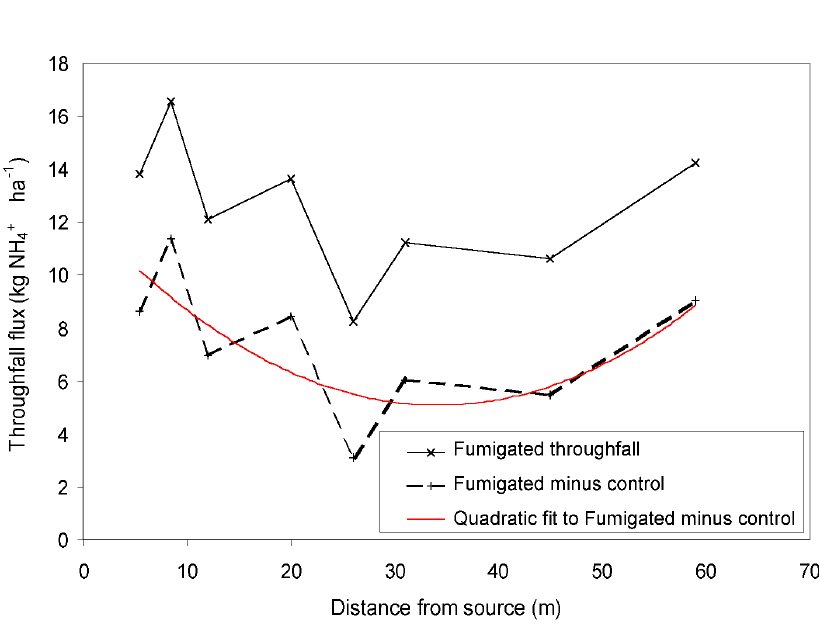
FIGURE 6. Total throughfall NH 4+ flux for different distances into the woodland measured over a period of 237 days. The net effect of the ammonia release is shown by the line representing the difference between throughfall under the fumigated trees and under control (unfumigated) trees.